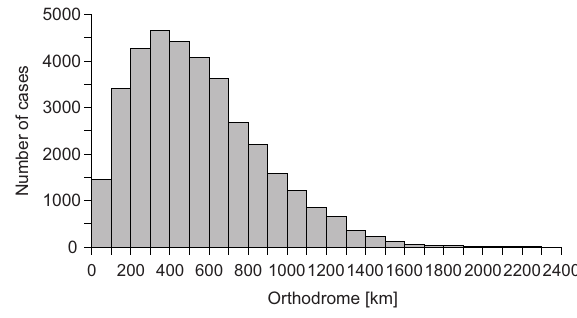
Fig. 2. Distribution of great circle values [km] determining the distance of the station where Mediterranean precipita- tion (MCP) occurred from the centre of the Mediterranean cyclone (MEC) (according to data from the period 1958–2008)